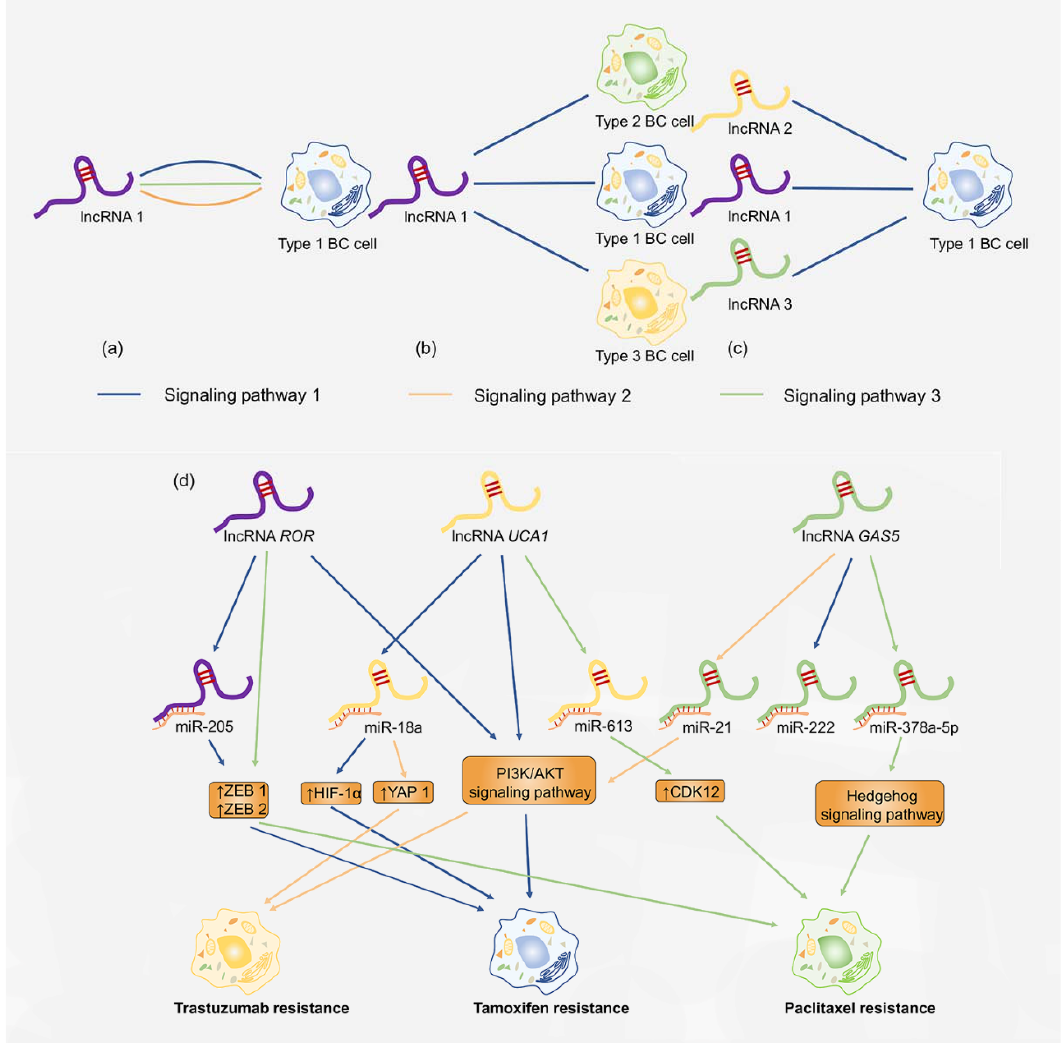
Figure 8. Brief sketch map of our conclusions in this review. ( a ) A certain lncRNA regulates chemoresistance in a subtype of BC cell via various signalling pathways; ( b ) a certain lncRNA induces different subtypes of BC cells to resist chemotherapeutic agents via the same signalling pathway; ( c ) a certain subtype of BC cell is regulated by various lncRNAs via the same signalling pathway. ( d ) The lncRNAs UCA1 , ROR and GAS5 are used as examples to provide a further detailed explanation.